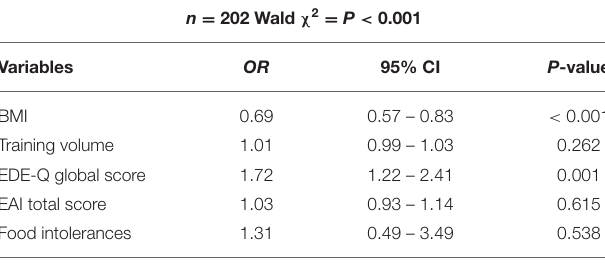
TABLE 4 | Risk factors for low energy